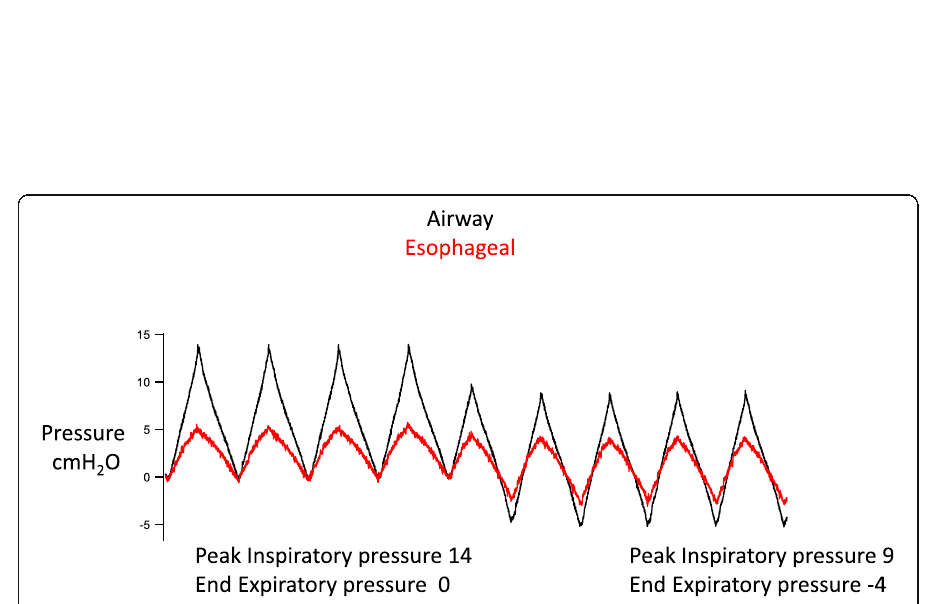
Fig. 5 Example of the effect of expiratory ventilation assistance on esophageal